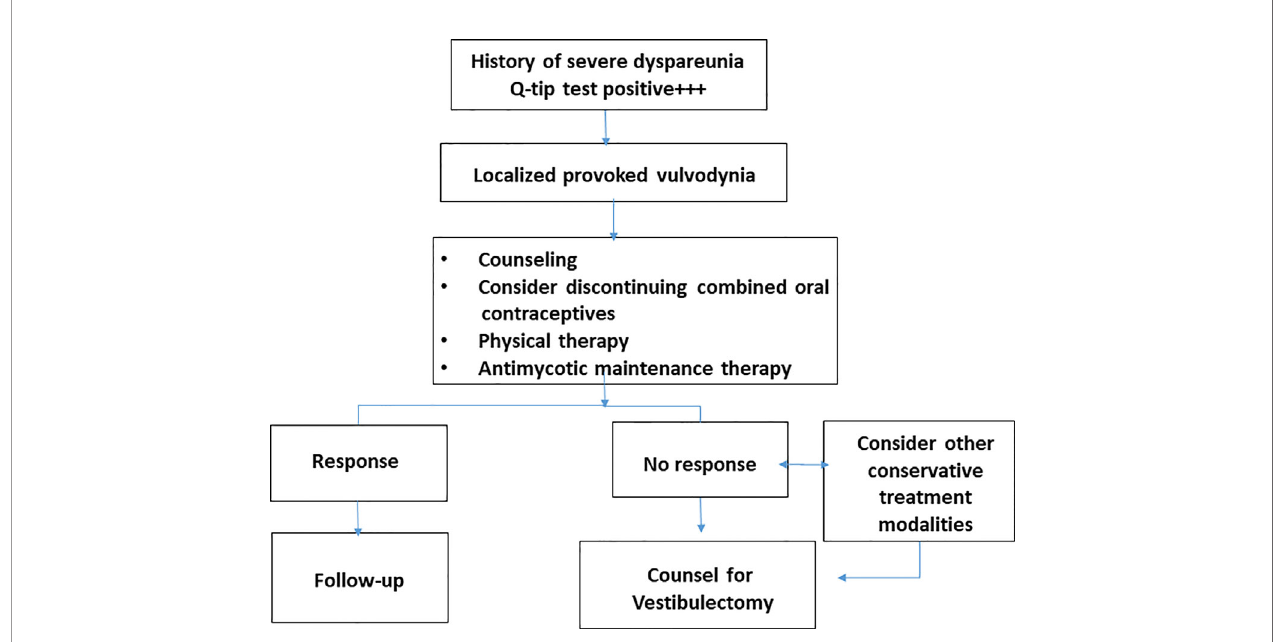
FIGURE 3 | Clinical algorithm developed by the authors and recommended for the management of patients with severe vulvar vestibulitis syndrome.